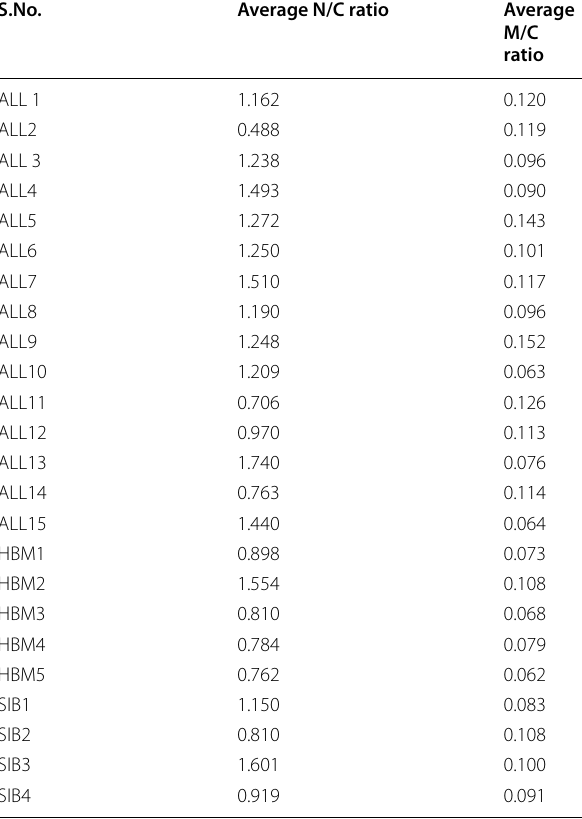
Table 2 Descriptive table showing the average N/C and M/C ratios recorded in lymphoblasts from sections of ALL patients and lymphocytes in controls